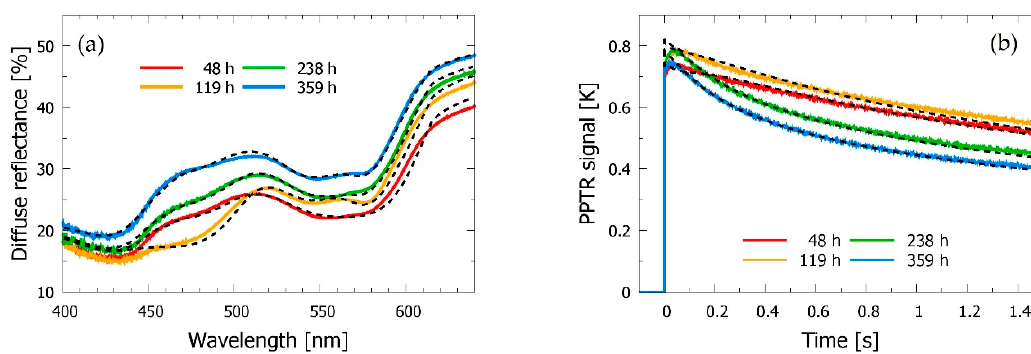
Figure 7. ( a ) DRS spectra and ( b ) PPTR signals obtained from a bruised site in subject a at four different time points (see the legend), and the corresponding model predictions (dashed lines).